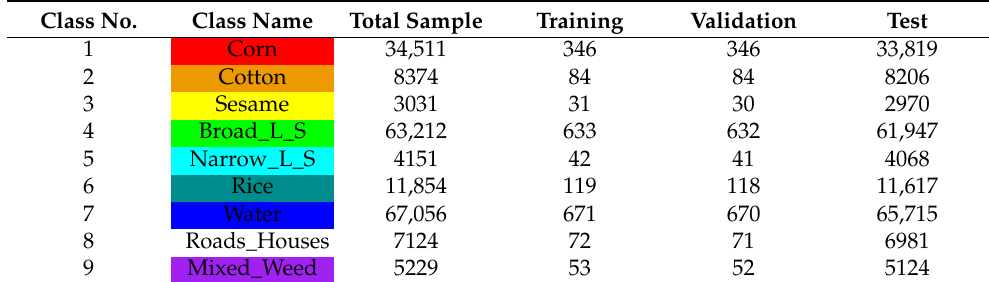
Table 4. The number of training sets and test samples covered by each surface selected on the LK dataset, and the number of all in each